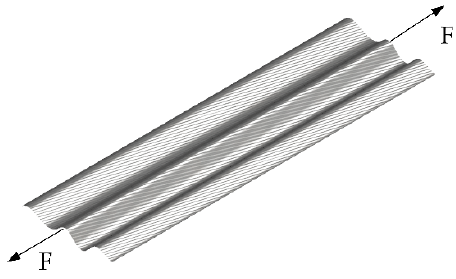
Figure 4. Wrinkling of initially planar unidirectional (UD) ply due to shear buckling in off-axis tensile test.